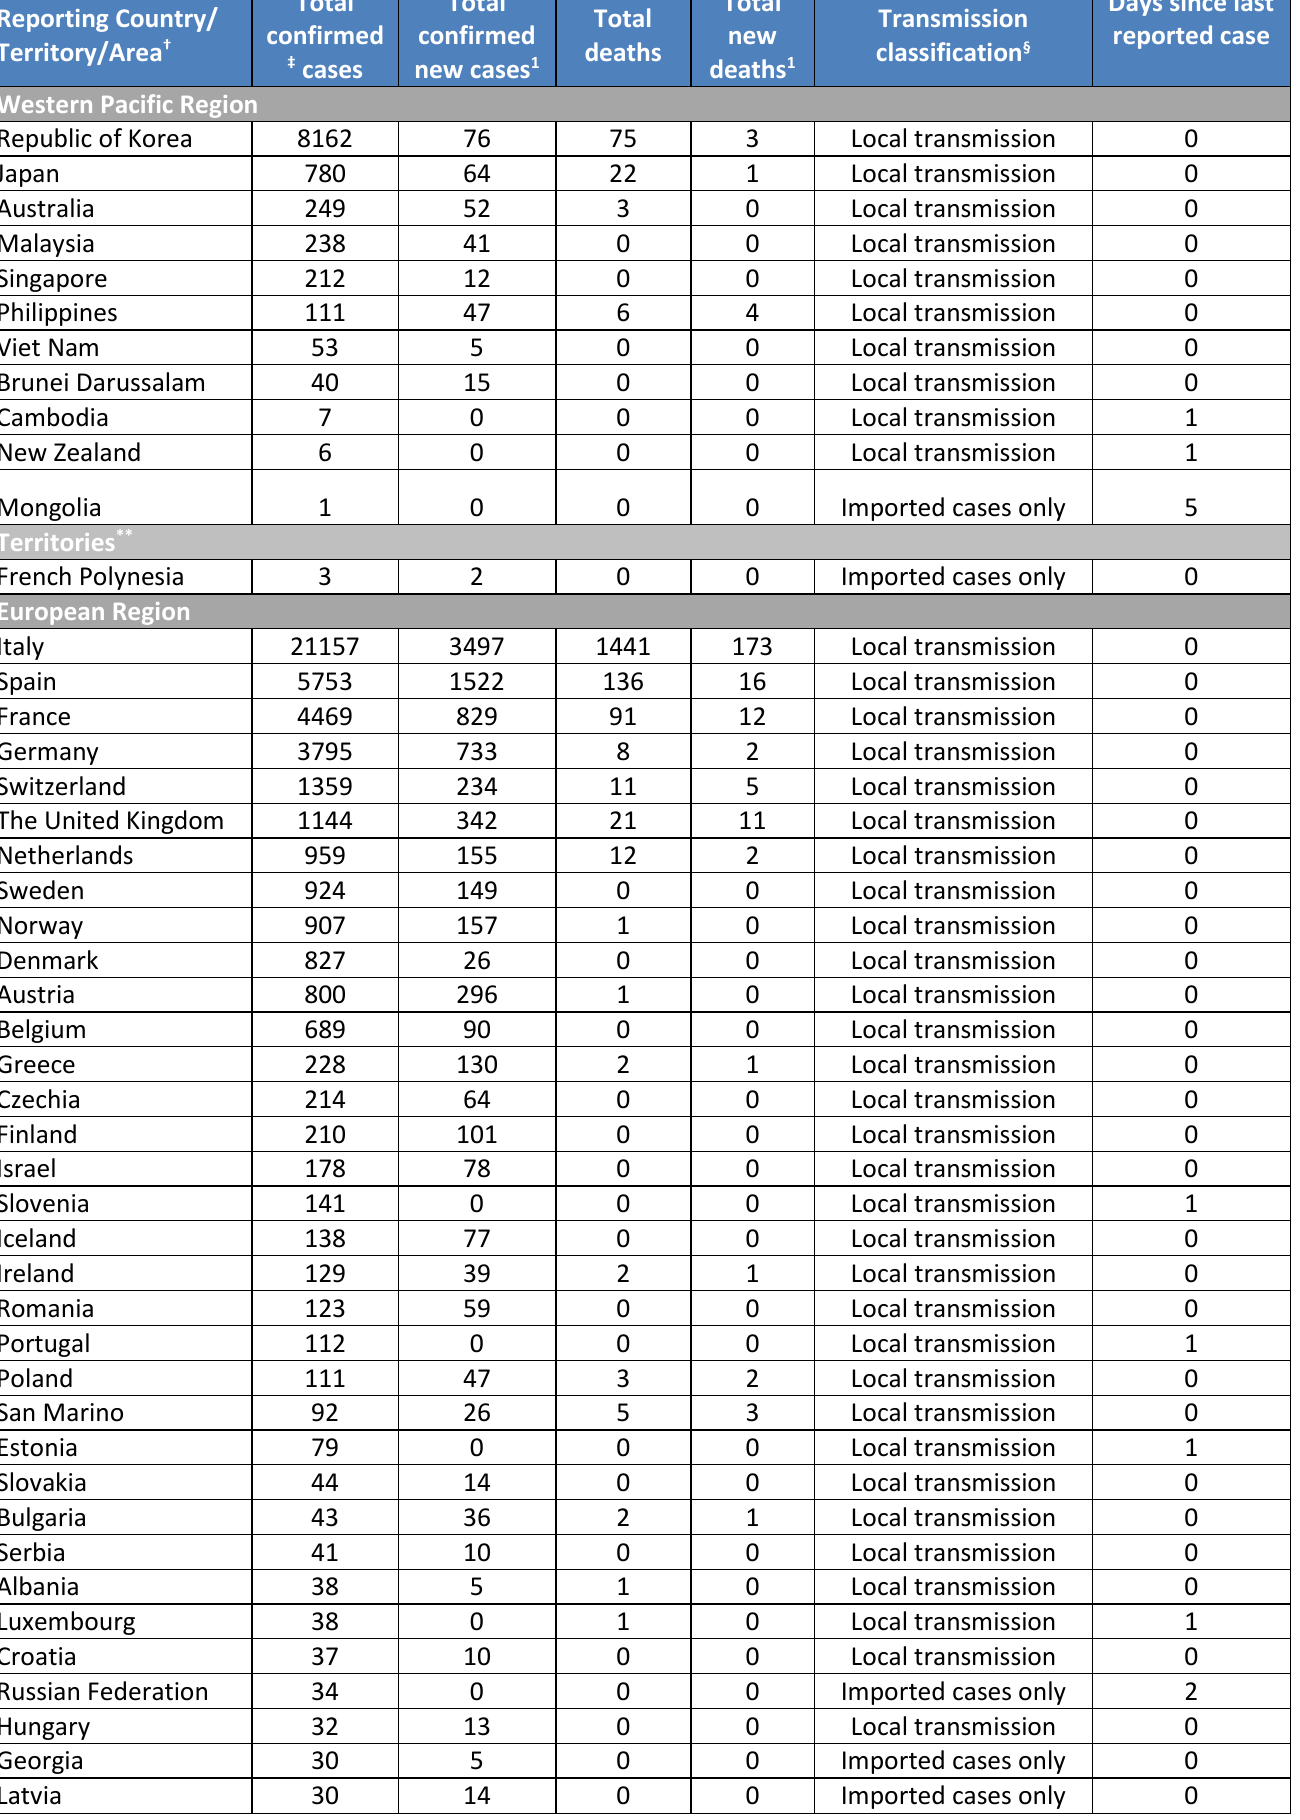
Table 2. Countries, territories or areas outside China with reported laboratory-confirmed COVID-19 cases